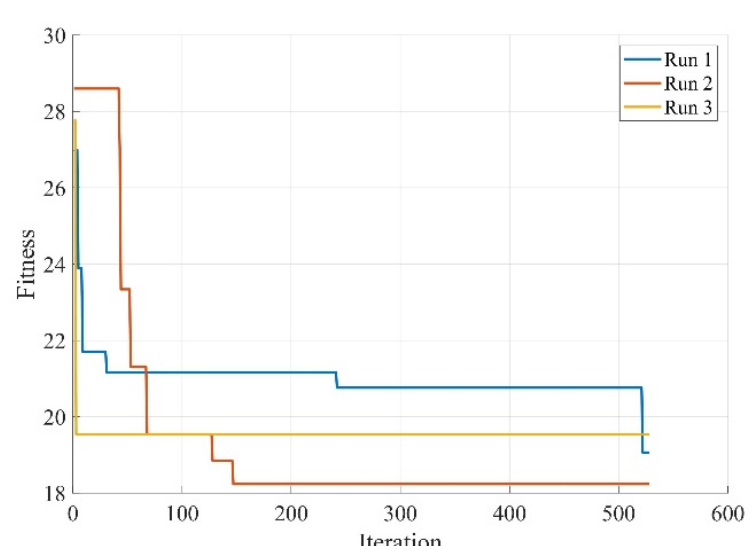
Figure 27. Fitness of different optimisation runs for membership functions (MFs) optimisation for dynamic search strategy selection over iterations.